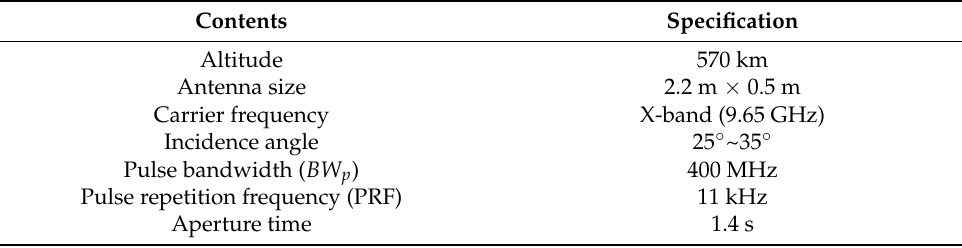
Table 2. Specification of the multistatic SAR microsatellite [29].